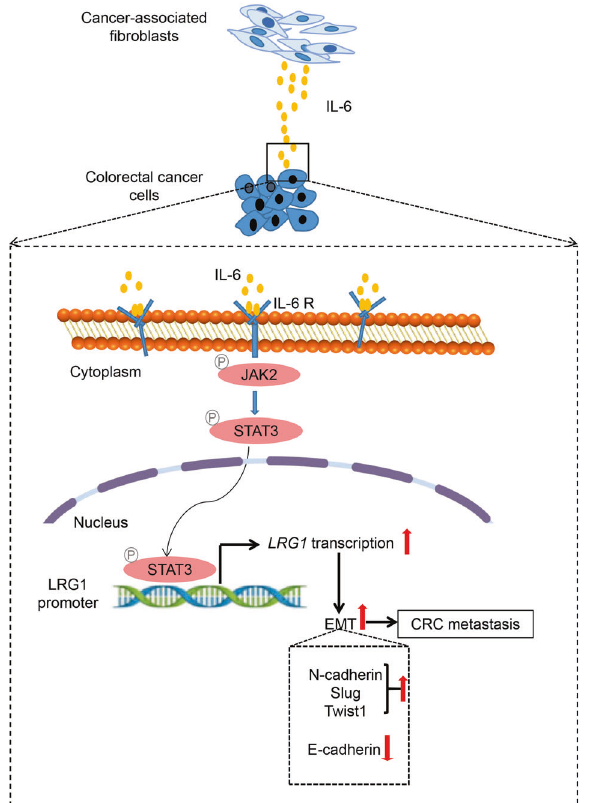
Fig. 7 The proposed model for CAFs-derived IL-6/STAT3/LRG1 axis in promoting metastasis of CRC. Scheme diagram depicting the underlying mechanism involved in metastasis of CRC mediated by CAFs. CAFs-derived IL-6 is able to activate JAK2-STAT3 in cancer cells. As a master transcriptional factor, STAT3 directly binds to LRG1 promoter, thus leading to upregulation of LRG1. LRG1